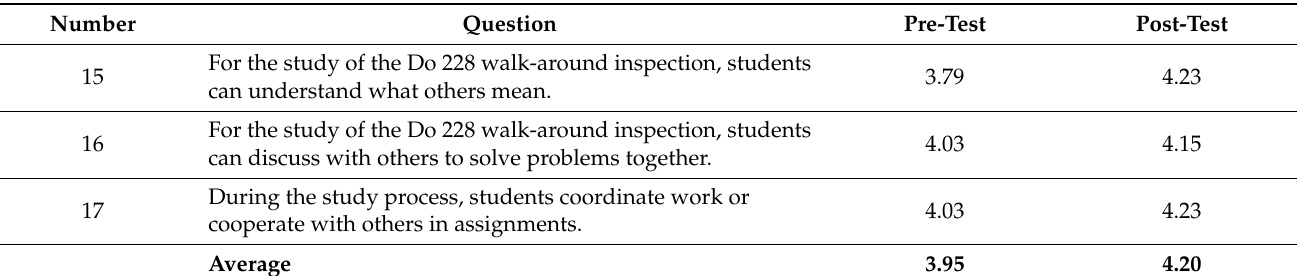
Figure 11. Students’ problem-solving ability in the previous test and the post-test. Table 7. Results for the teamwork.